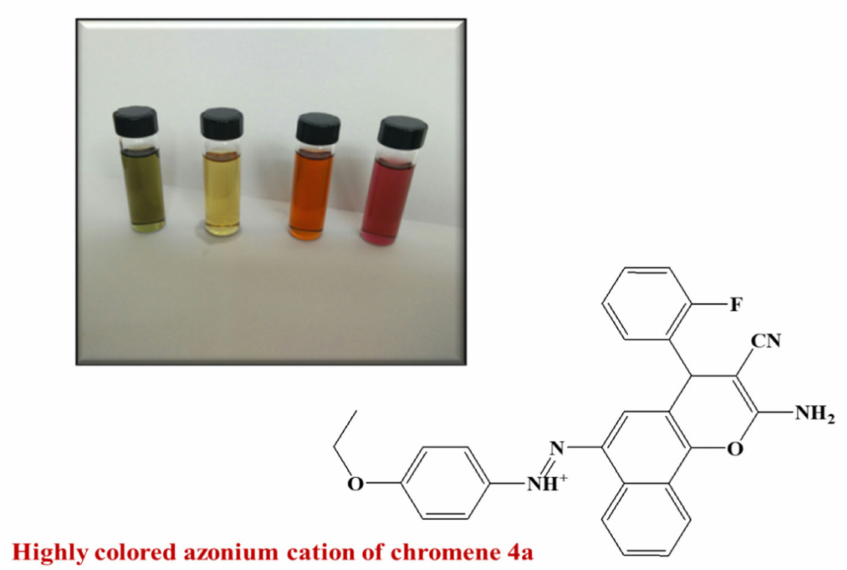
Figure 3. Color change of 4a in the presence of increasing [H + ] in a